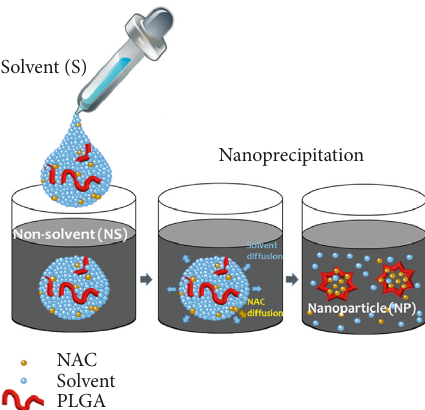
Figure 1: PLGA nanoparticle production scheme by nano- precipitation